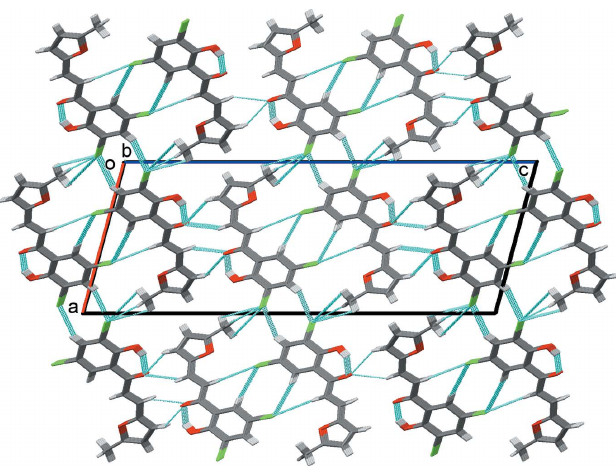
Figure 3 A view along the b axis of the crystal packing of the title compound. The hydrogen bonds (Table 1) and short contacts (Table 2) in the crystal structure are shown as dashed